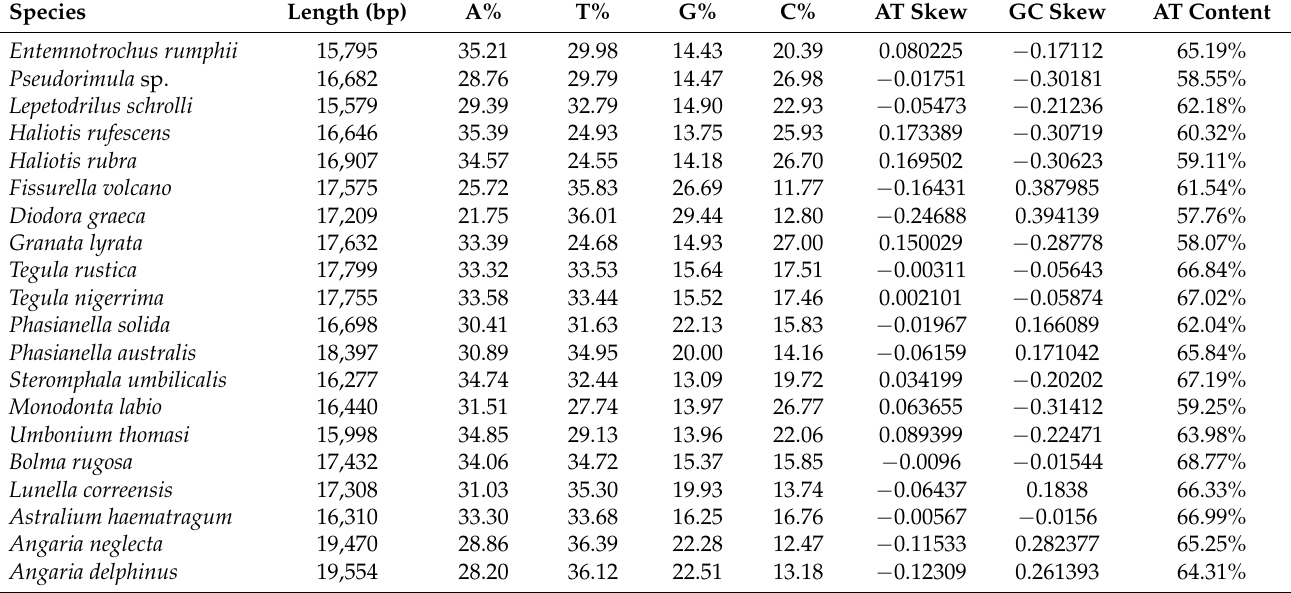
Table 3. Nucleotide composition of mitochondrial genomes of